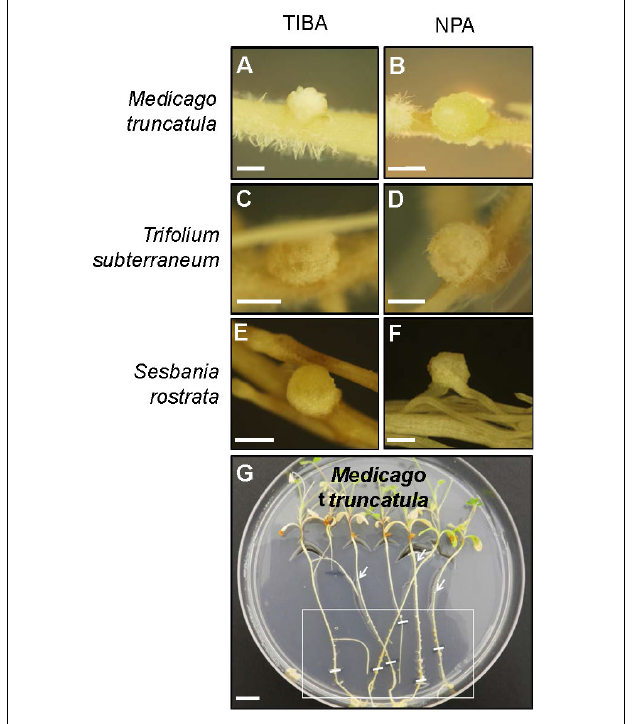
FIGURE 5 | Pseudonodule formation on the roots of legumes in response to TIBA or NPA treatments. Pseudonodules formed on the roots of (A,B) M. truncatula , (C,D) T. subterraneum (subclover), and (E,F) Sesbania rostrata , in response to treatment with either 50 µ M TIBA or 50 µ M NPA. (G) Pseudonodules were formed along the entire roots of M. truncatula . The area on the roots encapsulated by the white box indicates the region where the majority of pseudonodules were found on each root. White lines within the box indicate locations of the root tip when the roots were first subjected to TIBA treatment. White arrows indicate pseudonodules found at older parts of the roots. Scale bars represent 1 mm in (A–F) and 1 cm in (G) . Abbreviations: TIBA, 2,3,5-triiodobenzoic acid and NPA, 1- N -naphthylphthalamic acid.